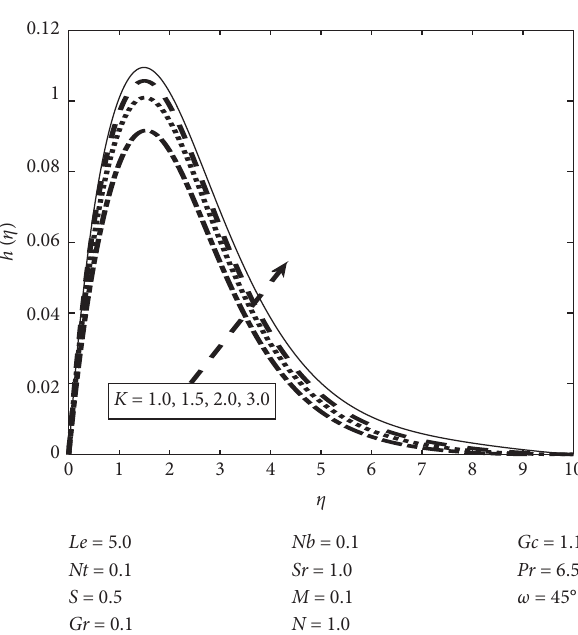
Figure 4: Angular velocity profile for several values of K